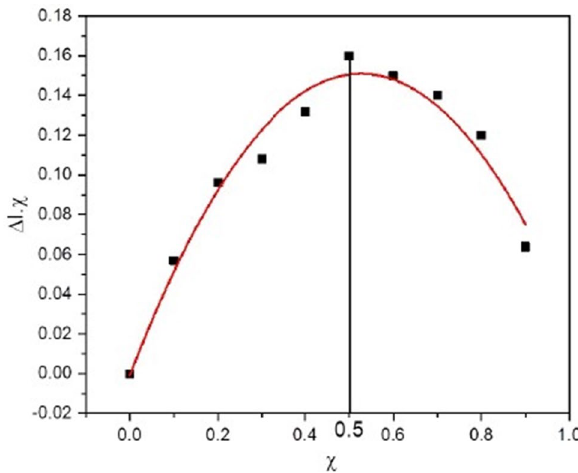
Figure 9. Job’s plot display binding stoichiometry of BSA with 4g.